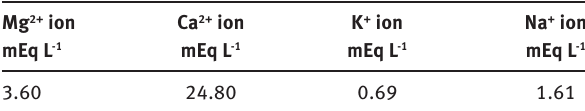
Table 1: Metal ion analysis of soil samples collected from the habitat of the Gypsophila aretioides